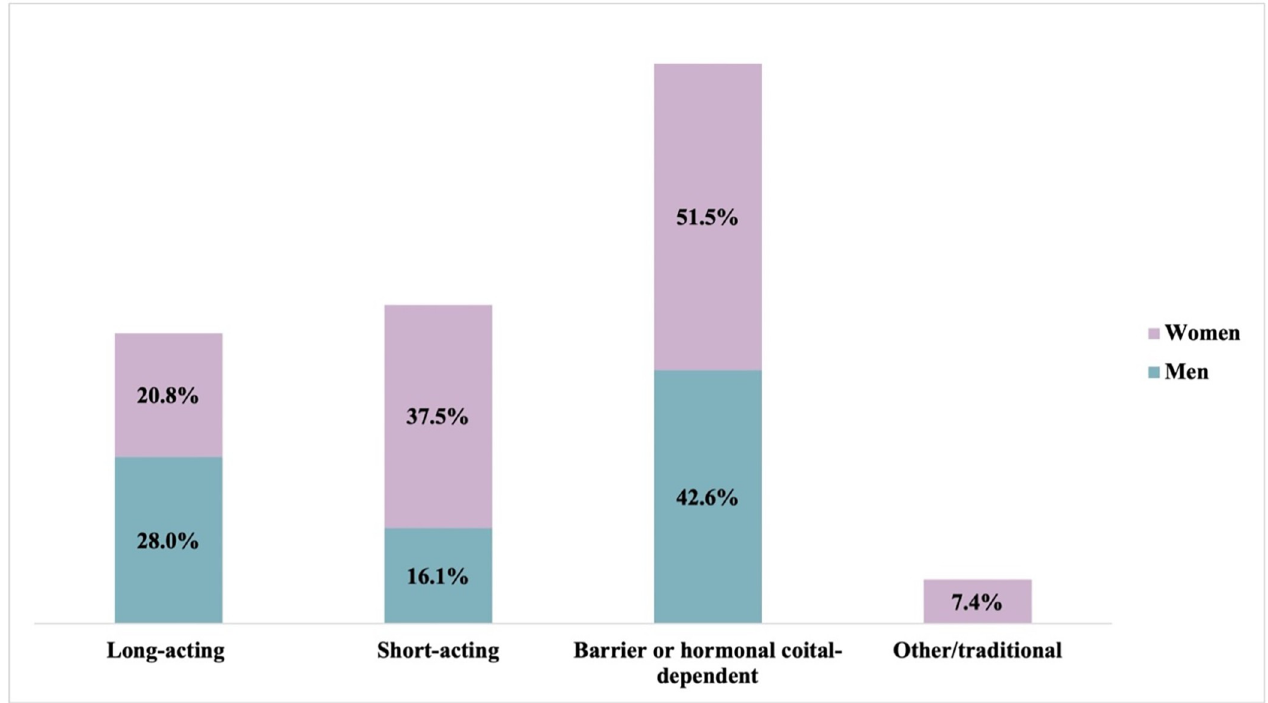
Fig 1. Difficulty accessing contraception by method effectiveness, by gender. Method effectiveness: Long-acting reversible contraception = intrauterine device (IUD), implant; short-acting = injectable, pills; hormonal/barrier coital-dependent = emergency contraception.